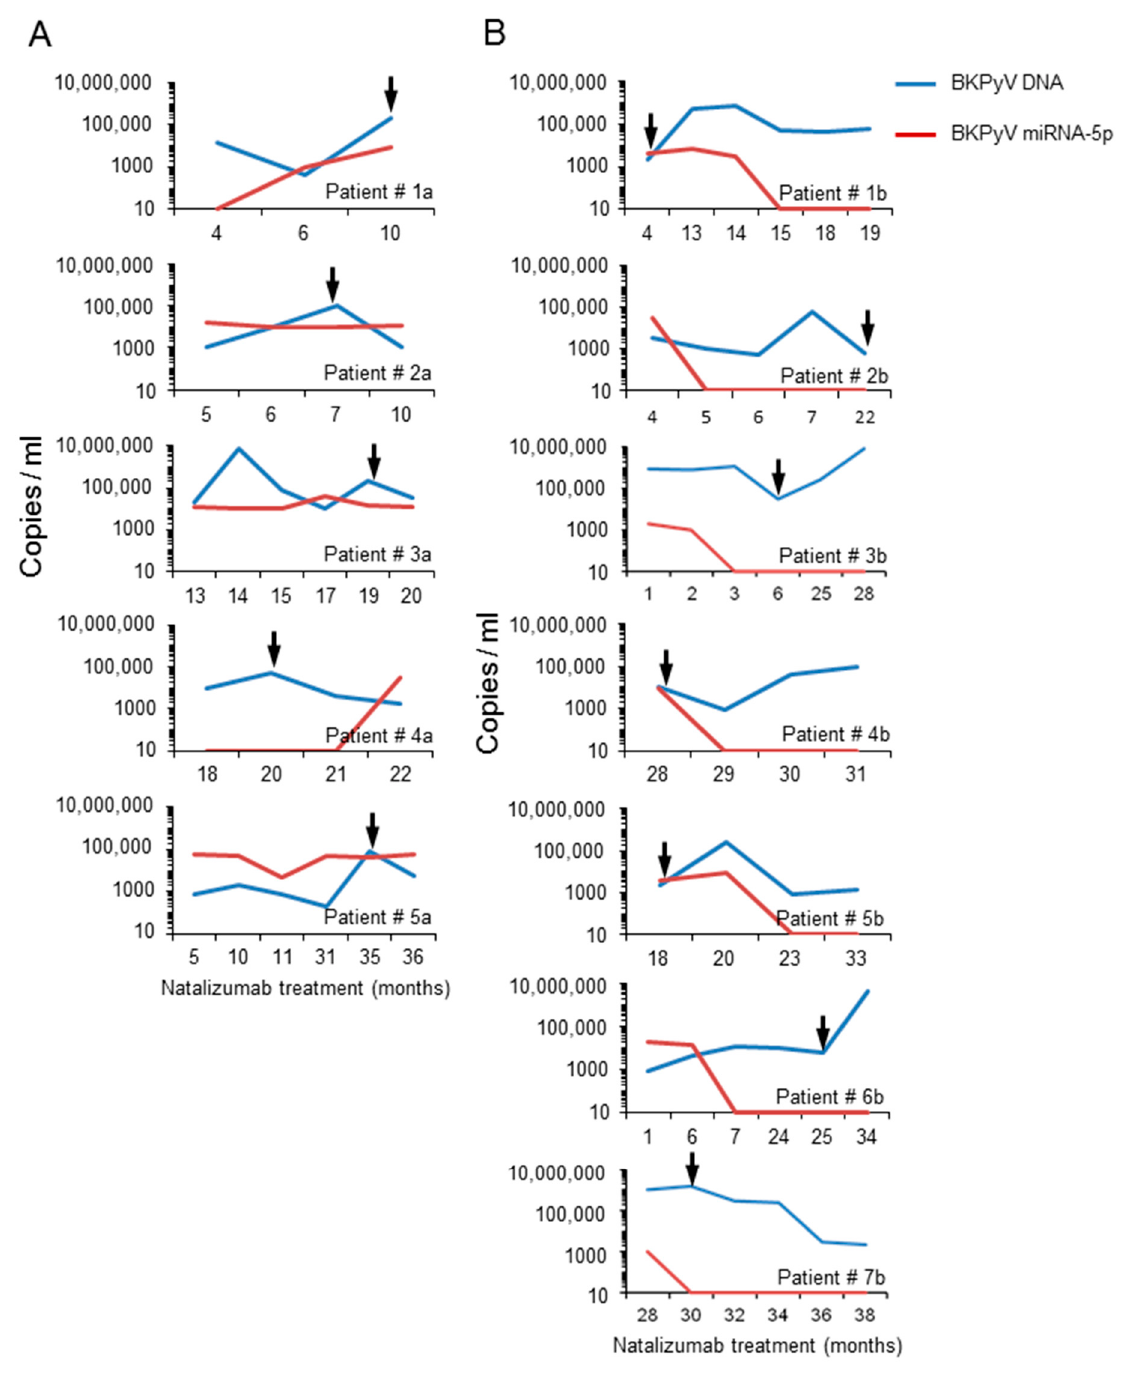
Figure 7. BKPyV DNA viral load and miRNA-5p expression in urine samples from multiple sclerosis patients. Urine sample were analysed over indicated time of follow-up and at the indicated time points, urine BKPyV loads and miRNA levels in exosome preparations were determined. Arrows indicate the time at which NCCR sequence was obtained from urine samples. Panels on the left show the results obtained for 5 patients with BKPyV carrying archetype NCCRs (patient ID 1a–5a); Panels on right show those with rearranged NCCR-BKPyV (patient ID 1b–7b).